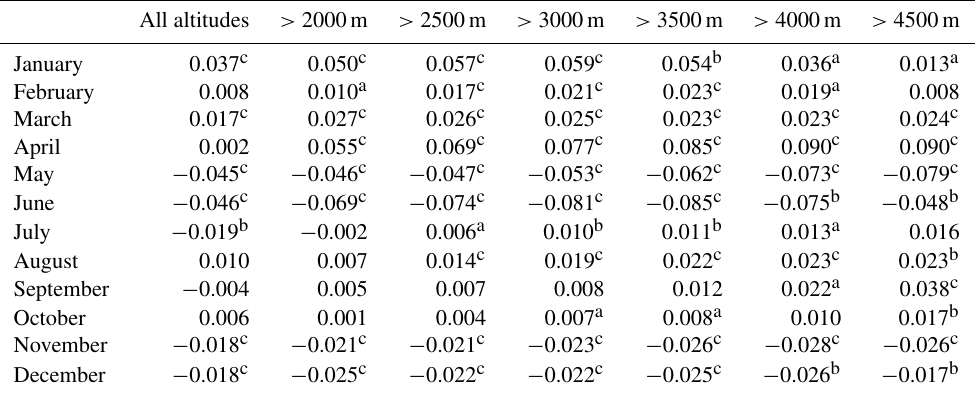
Table 7. Significance of elevation-dependent warming for monthly T max above different altitude thresholds based on the CTMD from 1979 to